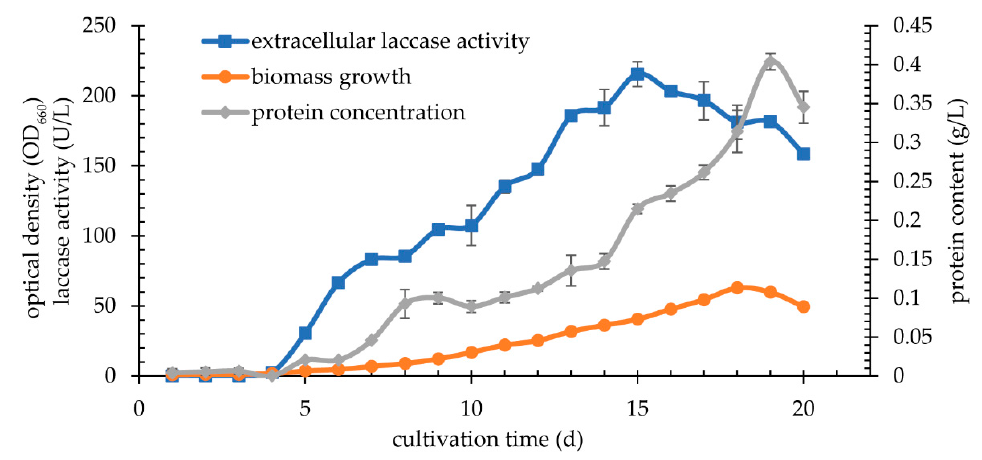
Figure 8. Kinetic of cultivation K. bupleuri G3 in BSG medium.